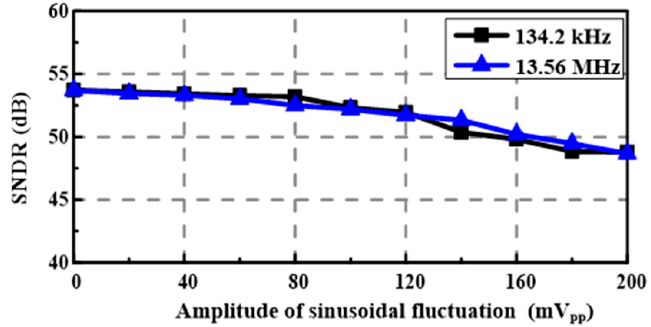
Figure 8. The SNDR versus the amplitude of sinusoidal fluctuation added to the 0.8 V power supply.